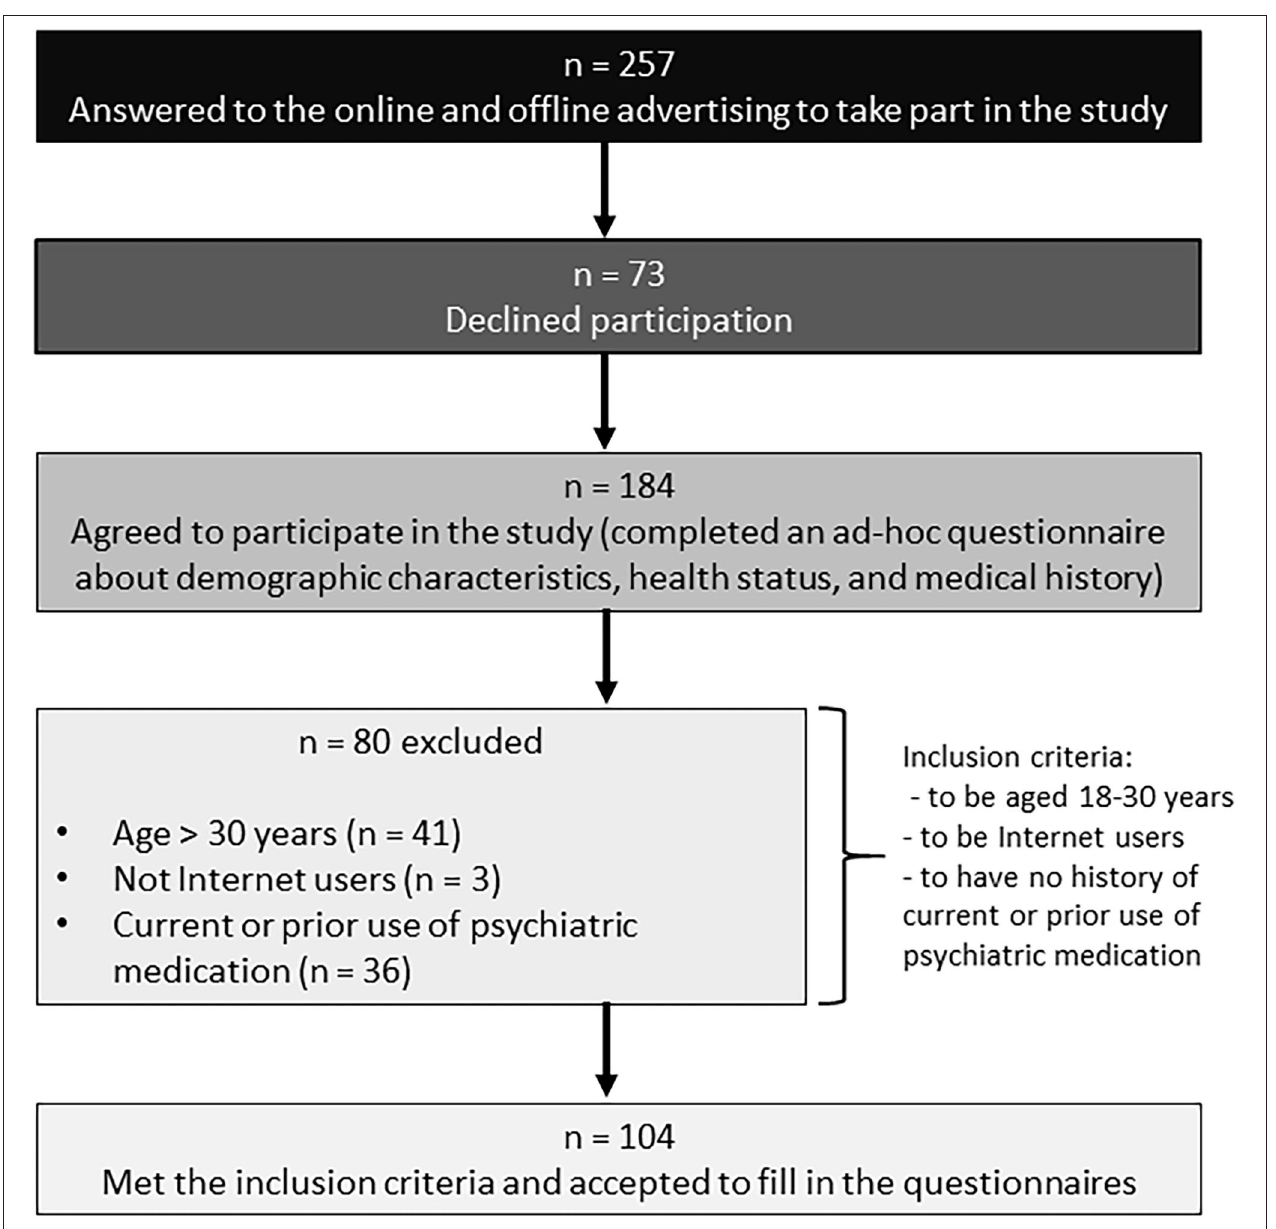
FIGURE 1 | Recruitment flow